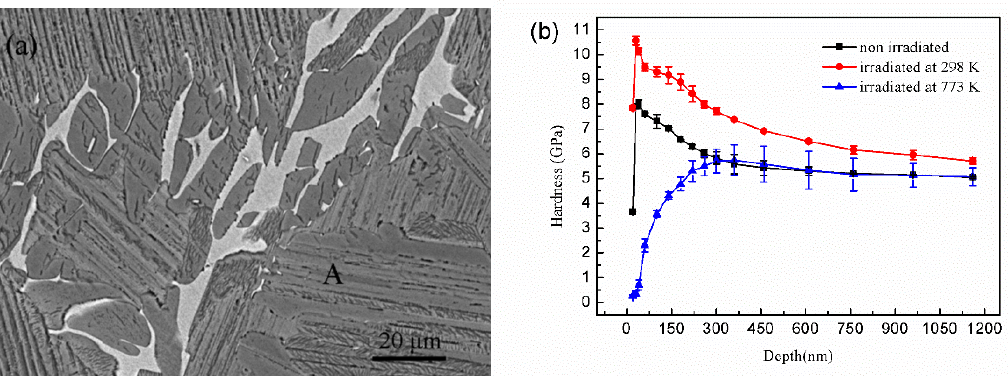
Figure 7. Nanoindentation hardness of the experimental high Nb-containing TiAl alloy. ( a ) The position of nanoindentation tests in the alloy: A lamellar colony, ( b ) The curve of nanohardness with depth in lamellar colony before and after ion implantation of as-cast alloy.